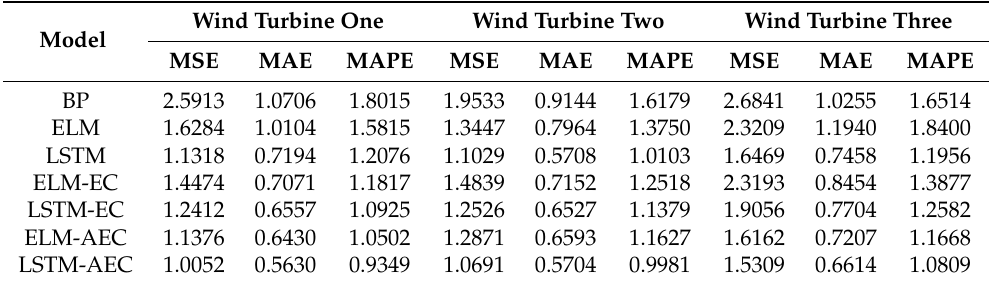
Table 3. Performance evaluations of different models for gearbox input shaft temperature prediction.